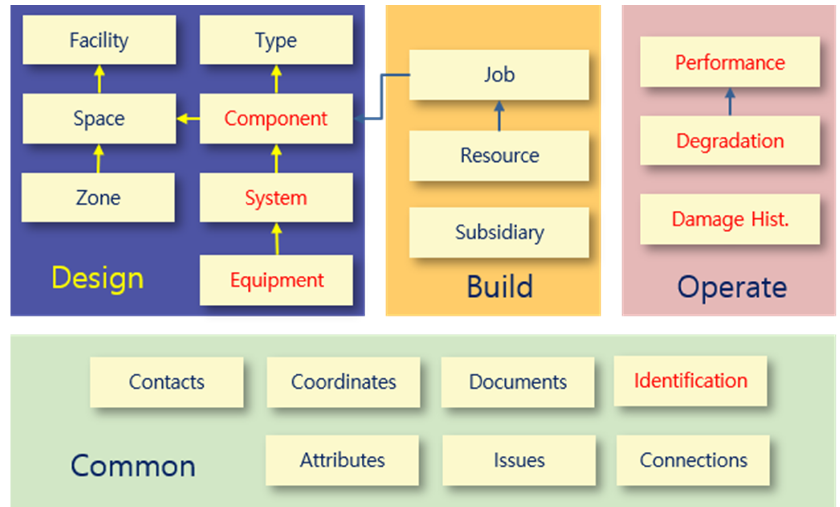
Figure 7. Configuration of port BIM-based COBie worksheet.